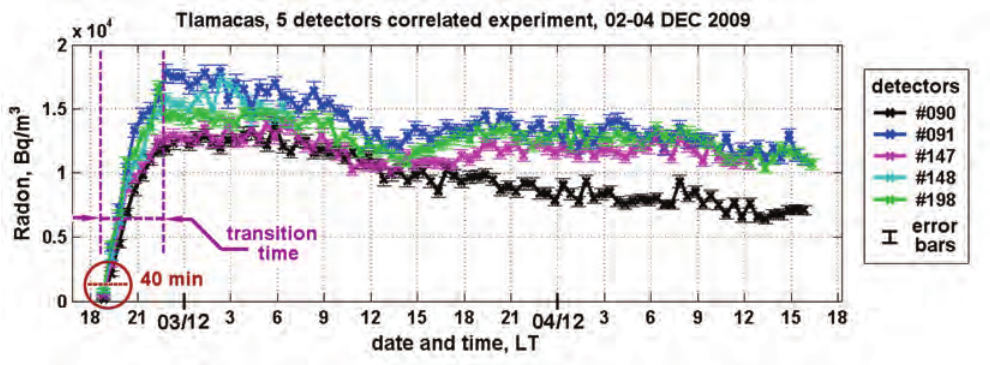
Figure 4. Correlated radon emission measurements for the five detectors tested. Tlamacas station site, December 2-4, 2009 (30 min sampling time).